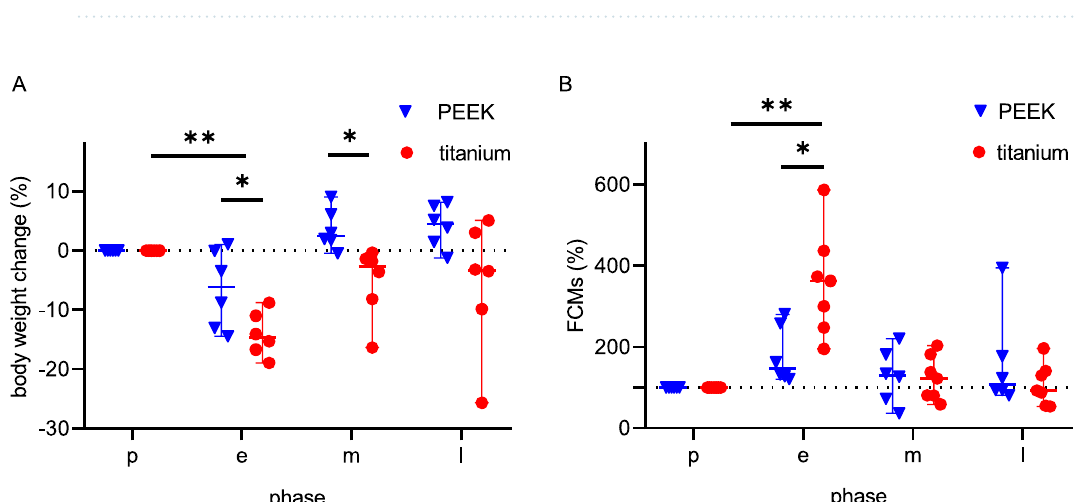
Figure 4. Changes in body weight and faecal corticosterone metabolite (FCM) concentrations after dorsal skinfold chamber implantation. Individual values are given over time in a preoperative phase (p), early postoperative phase (e), middle postoperative phase (m) and late postoperative (l) phase. Body weight change ( A ) between each time point was analysed by RM one-way ANOVA on ranks followed by Dunn’s correction, and the difference between each group was analysed by unpaired t test followed by two-tailed P value tests. FCM concentrations ( B ) between each time point was analysed by Friedman test followed by Dunn’s correction, and the difference between each group was analysed by unpaired t test followed by two-tailed P value tests. *p < 0.05; **p < 0.05; PEEK: n = 6, titanium: n =